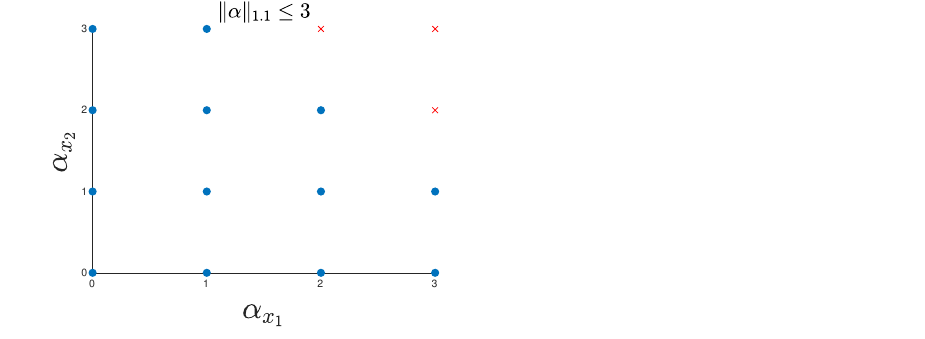
Figure 1. Retained indices for the approximation of the Koopman operator for the competition model when choosing q = 1.1 and p = 3.